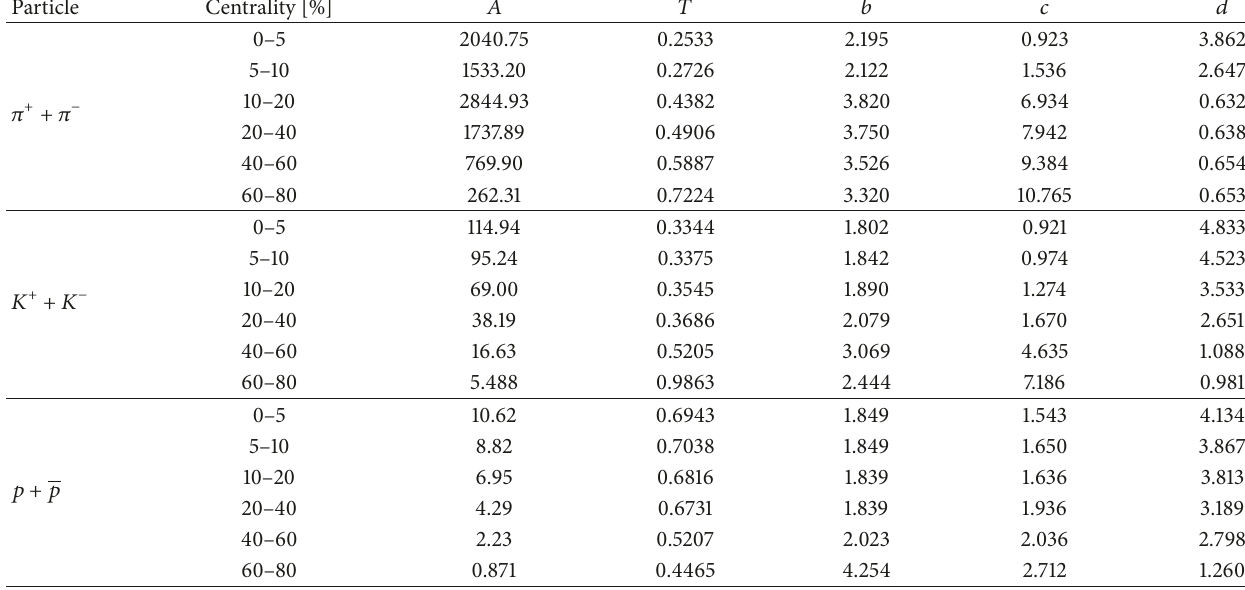
Table 2: The fitting parameters for various particles with the generalized FP solution (8).